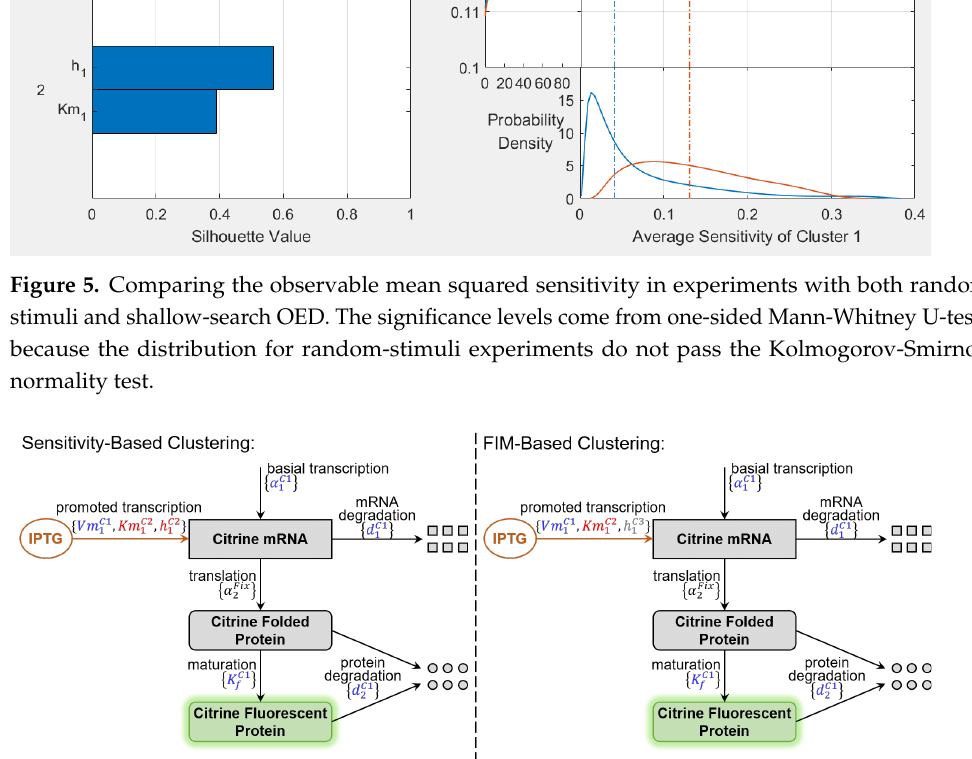
Figure 6. Results of the Sensitivity-based and FIM-based parameter clustering. Parameter clusters can be distinguished by colours and